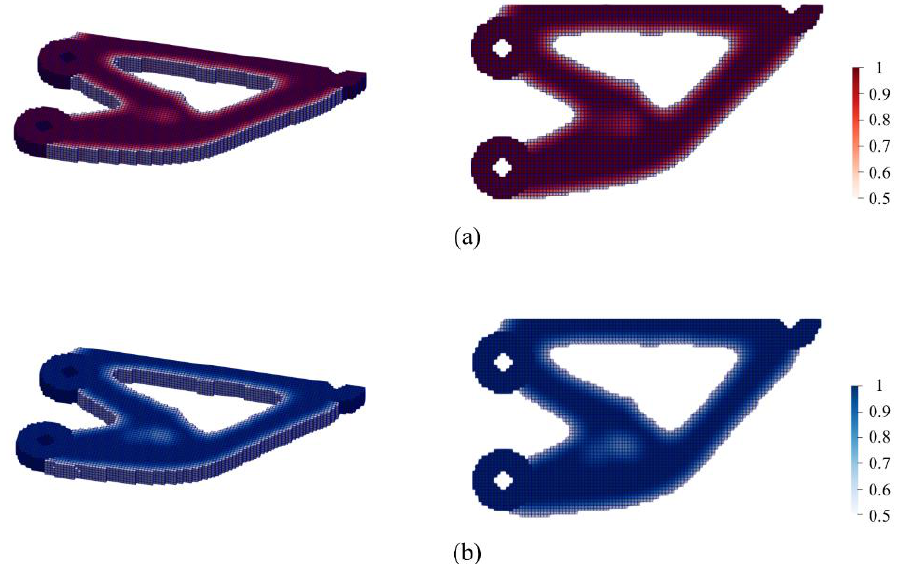
Figure 14. The convergence histories of the optimization processes from cross-infill initial guesses of ( a ) 90°-90° and ( b ) 90°-0°.